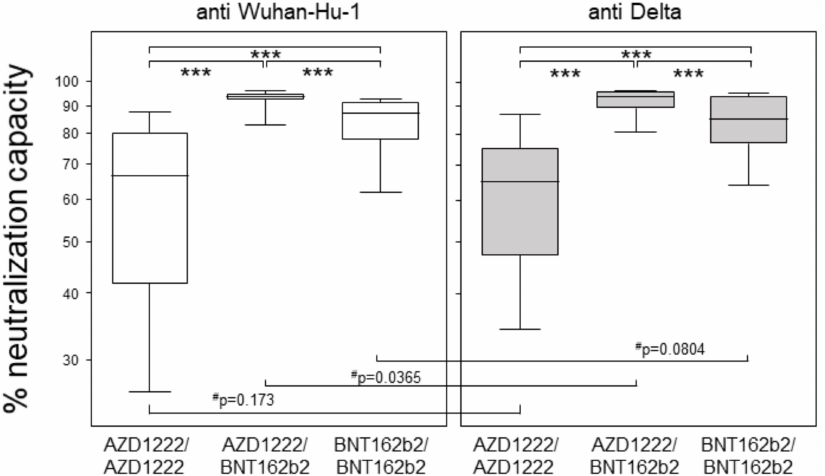
Figure 2. Heterologous prime-boost combining AZD1222 and BNT162b2 yielded highest neutral- ization capacities. Box plots indicate neutralizing capacities against the Wuhan-Hu-1 strain and the Delta Variant, respectively. Data are shown as percentages of neutralizing antibodies resulting from surrogate virus neutralization tests using RBD peptides. Asterisks indicate significant differences resulting from Kruskal-Wallis ( p < 0.0001) with Dunn ´ s multiple comparisons test, with *** represent- ing p < 0.001. The pound symbols ( # ) indicate p -values resulting from Wilcoxon matched pairs signed rank